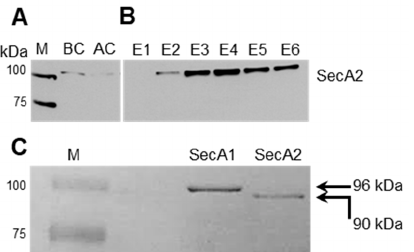
Figure 2. Affinity chromatography for SecA2. ( A , B ) Identification of SecA2 in cytosolic fractions BC (before column), AC (after column) and elution fractions (E1–E6) using specific anti-SecA2 antibody; and ( C ) comparison of affinity chromatography purified Strep-tagged SecA1 (96 kDa) and SecA2 (90 kDa). M = Size ladder.